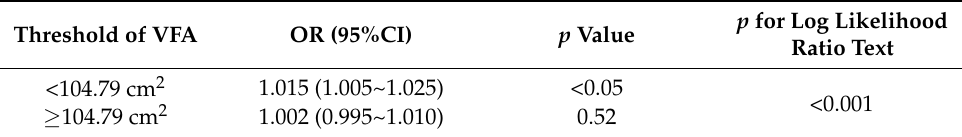
Table 4. Threshold effect analysis of VFA and HUA in males using the two-piecewise linear regression